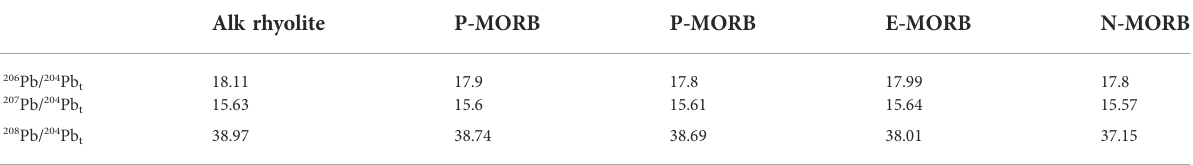
TABLE 1 ( Continued ) Bulk rock geochemical analysis of the Zarao Metavolcanic Rocks.